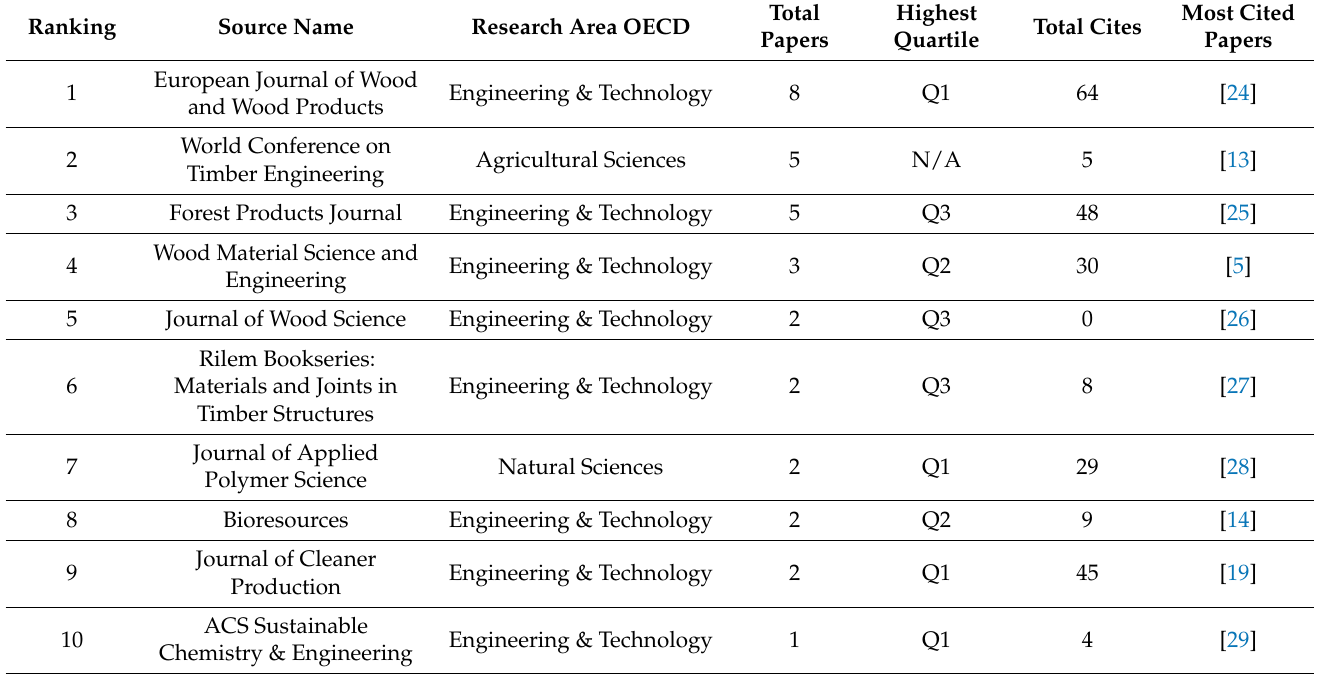
Table 1. Sources with the most significant impact and that publish the most about “Green Gluing”.